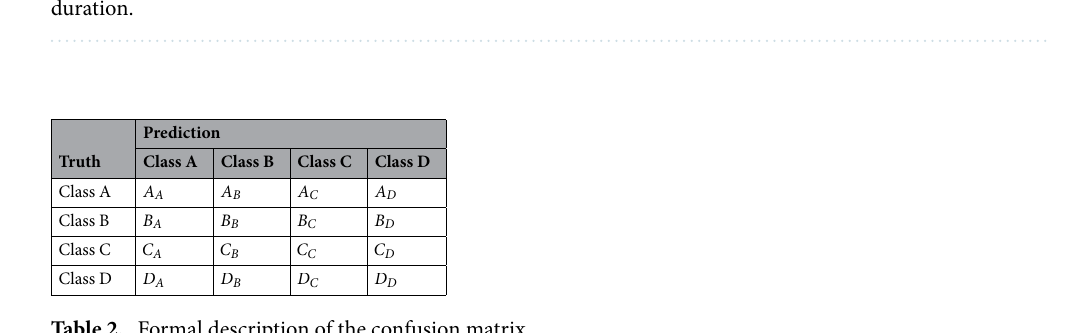
Table 2. Formal description of the confusion